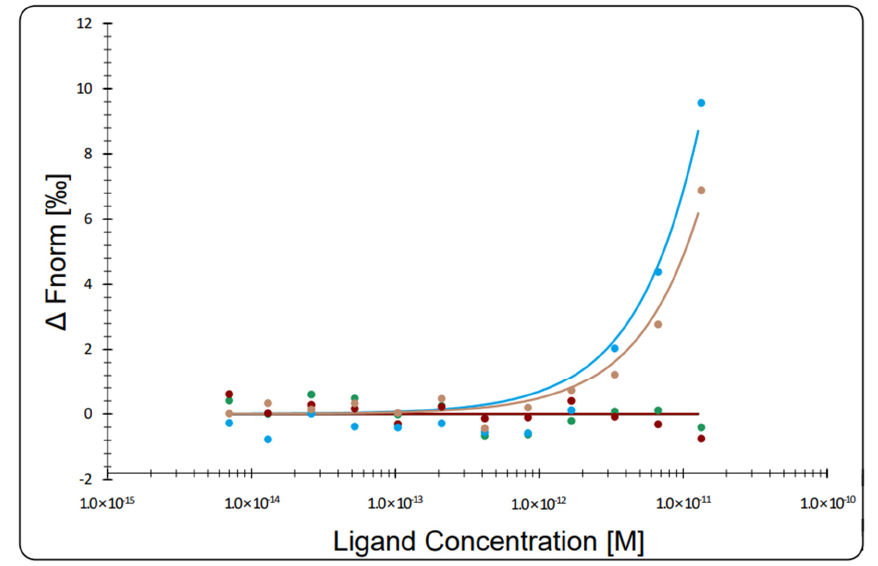
Figure 11. Thermophoretic assay to compare affinity between aptamers and Zika virus (ZIKV) and Dengue virus (DENGV) particles. The figure shows the plot of baseline-corrected normalized fluorescence ( Δ Fnorm) (‰) versus ligand concentration, in a heating time of five seconds.